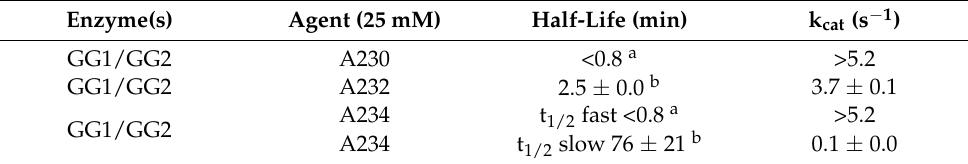
Table 3. Enzymatic degradation half-life of Novichok agents by a mixture of GG1 and GG2. Enzyme(s) Agent (25 mM) Half-Life (min) GG1/GG2